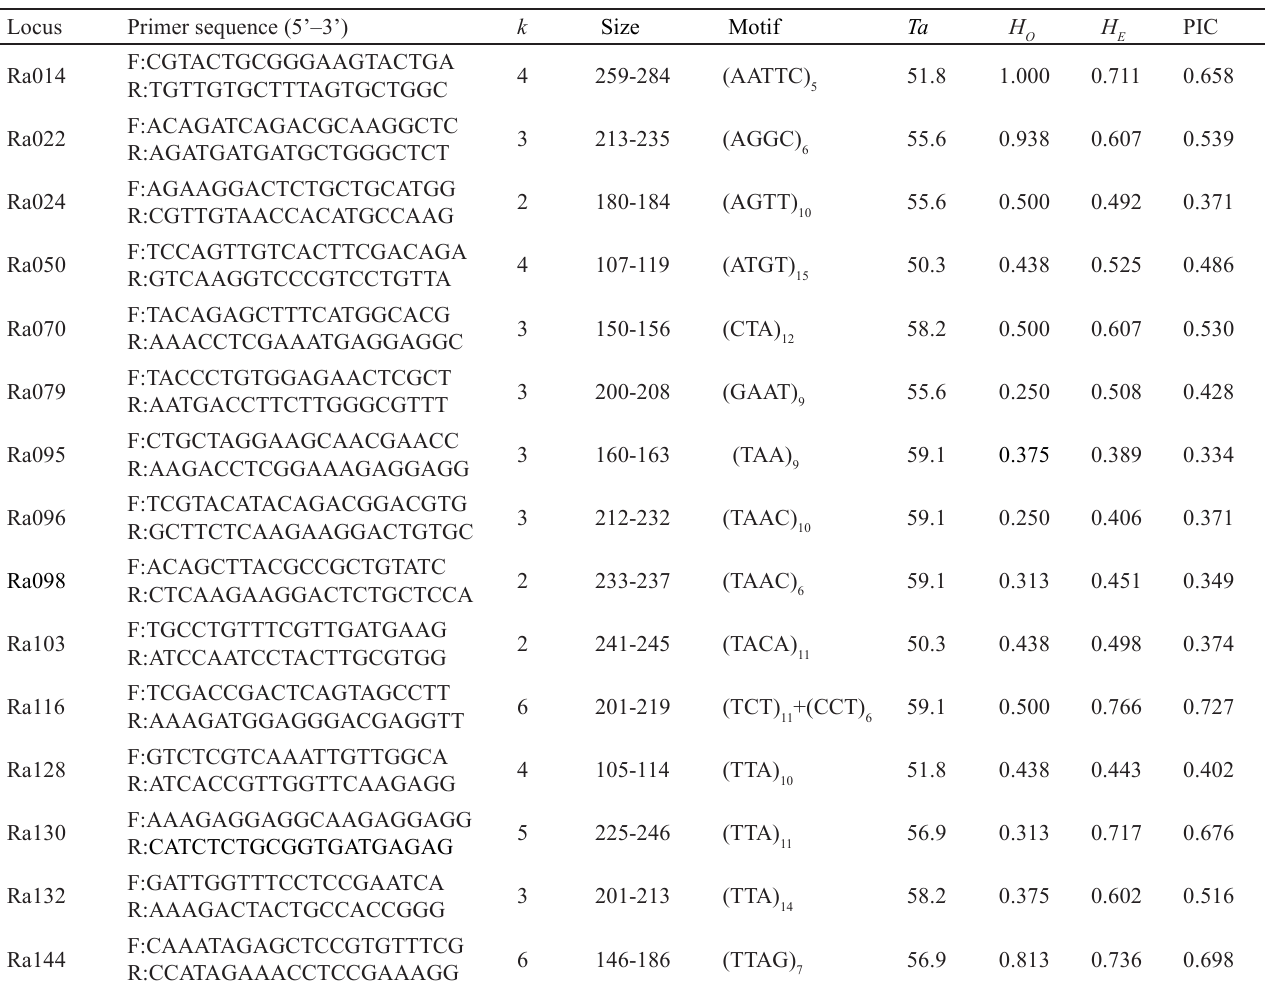
Table 1 . Highly polymorphic microsatellite primers in Reticulitermes aculabialis.